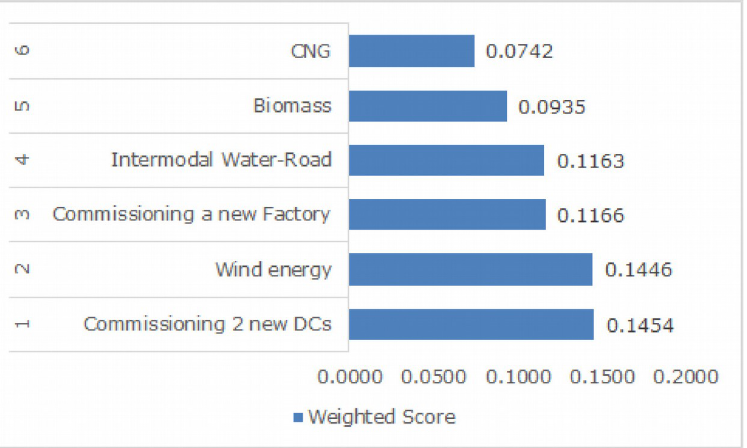
Figure 7. Results of the AHP